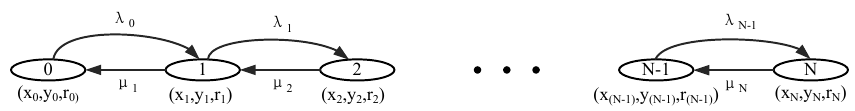
Figure 4. General analysis model for enhanced channel hopping mechanism in coexisting WBANs